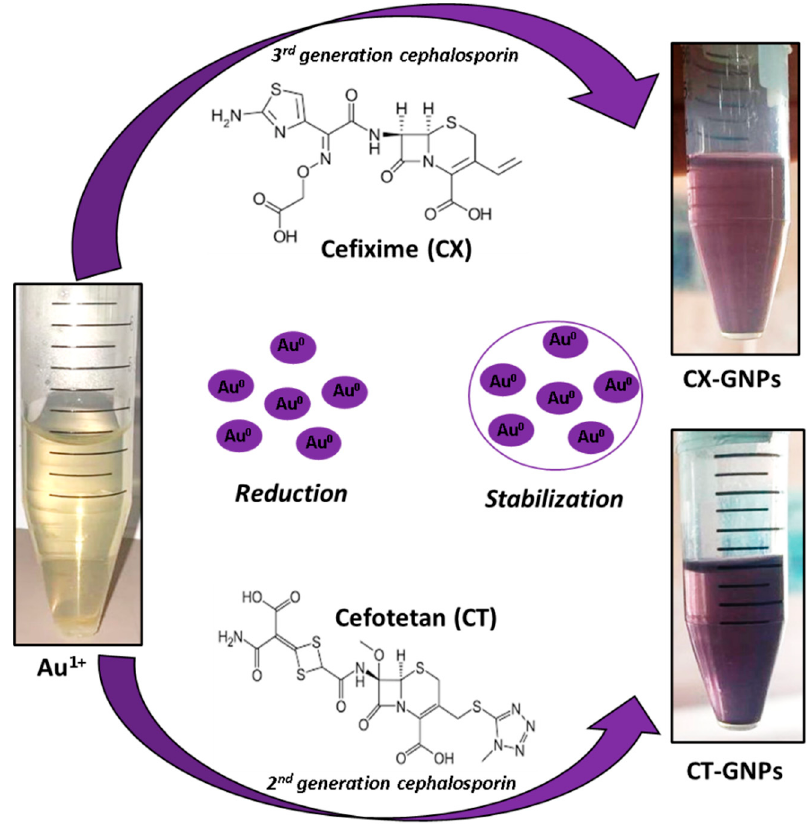
Figure 1. Schematic representation of AuNPs synthesis by cefotetan and cefixime. To synthesize AuNPs, CT and CX were added at 250 µ g concentration to the reaction mixture containing gold salt in pH 7.2 buffer. It has been reported that pH could influence AuNPs zeta potential and stability [48]. In fact, a recent study [49] has shown the influence of pH change on the size and zeta potential of AuNPs. The authors showed that a pH value from 6 to 10 was most appropriate for the synthesis of stable AuNPs. They also observed that acidic pH was unfavorable for AuNPs synthesis with almost neutral zeta potential, large size and aggregation. However, in the current study, the pH was kept at 7.2 (physiological pH) on the basis of earlier reports [11–16,42]. The color change from pale yellow to ruby red (Figure 1) visually confirmed the synthesis of CT- and CX-AuNPs. Both CT-AuNPs and CX-AuNPs were further characterized via spectrophotometry, zeta sizer and electron